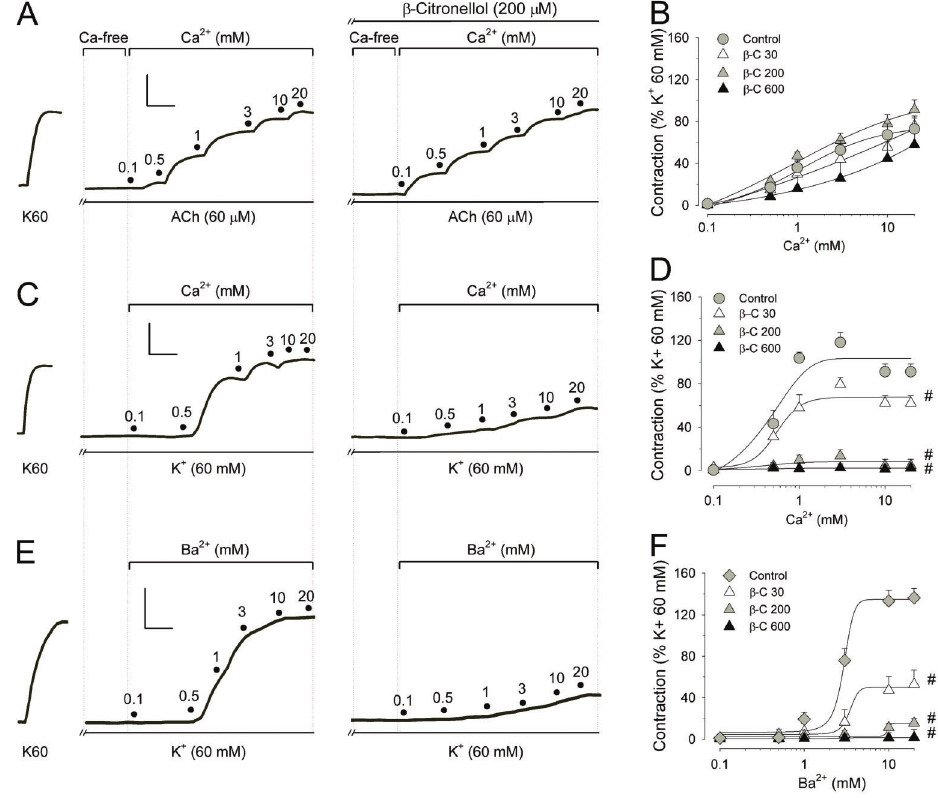
Figure 3. Inhibitory effects of b -citronellol on smooth-muscle contractions induced by recruitment of Ca 2 + from the extracellular medium. Left panels show typical traces of experiments conducted in tracheal preparations maintained in Ca 2 + -free medium (containing 4 mM EGTA; in A with EGTA + 10 m M verapamil) and stimulated with 60 m M acetylcholine (ACh) ( A ) or 60 mM K + ( C and E ). Under such conditions, force developed by tracheal preparations remained at resting levels until addition of increasing concentrations of Ca 2 + (0.1 – 20 mM; A and C ).